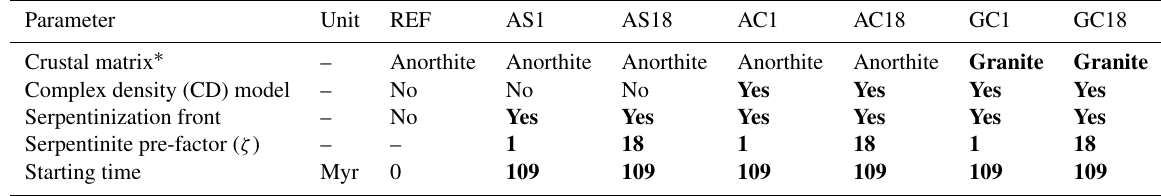
Table 1. Summary of all simulations presented in this study. Bold entries highlight the differences compared to the reference model REF. Parameter Unit REF AS1 AS18 AC1 AC18 GC1 GC18 Crustal matrix ∗ – Anorthite Anorthite Anorthite Anorthite Anorthite Granite Granite Complex density (CD) model – No No No Yes Yes Yes Yes Serpentinization front – No Yes Yes Yes Yes Yes Yes Serpentinite pre-factor ( ζ ) – – 1 18 1 18 1 18 Starting time Myr 0 109 109 109 109 109 109